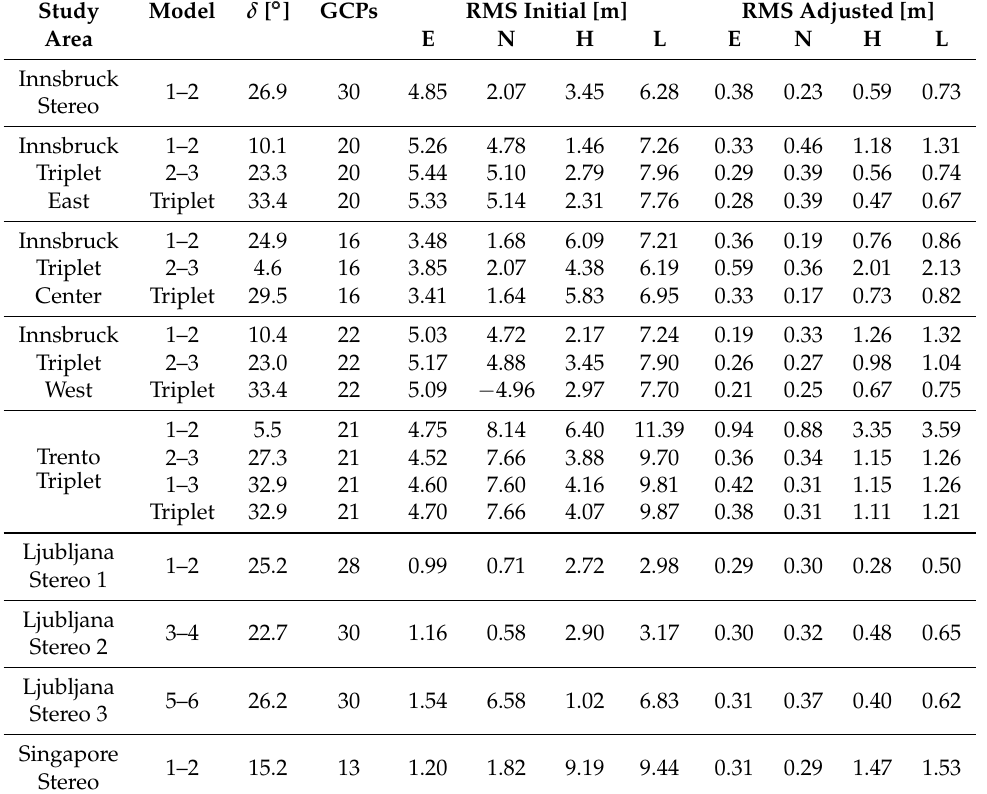
Table 6. 3D RMS residuals achieved from all initial as well as adjusted sensor models given in meters (with δ being the convergence angle). Values are given for East (E), North (N), Height (H) and their 3D Length